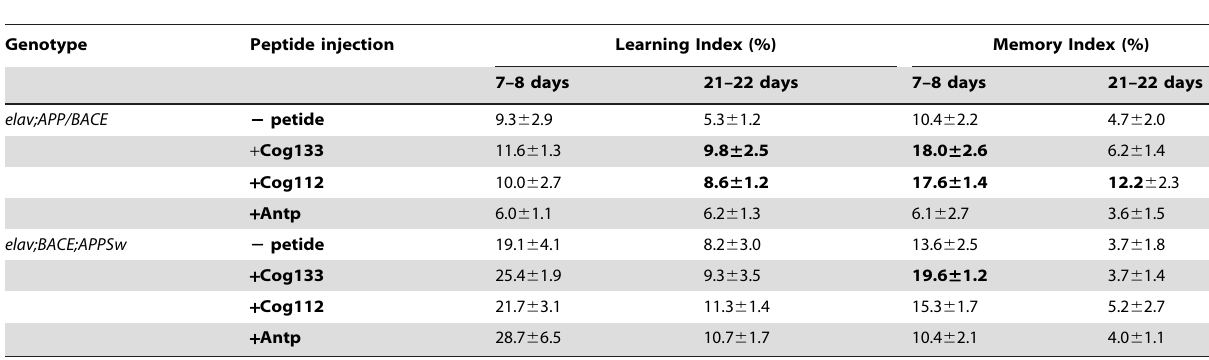
Table 3. Effect of COG133 and COG112 on learning and memory in APP -nransgenic flies.